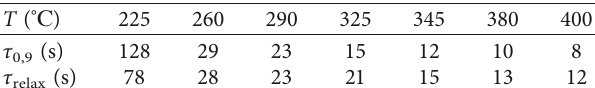
Figure 5: Change in conductivity in time for the 0.24wt.% Pd/ SnO 2 -based sensor at different operational temperatures when gas mixture surrounding the sensor was subsequently changed from air to 44 ppm H 2 in air ambient and from 44ppm H 2 to air. Table 2: Response ( τ 0,9 ) and recovery ( τ relax ) times to 44ppm H 2 in air ambient for the 0.24wt.% Pd/SnO 2 -based sensor at its different operational